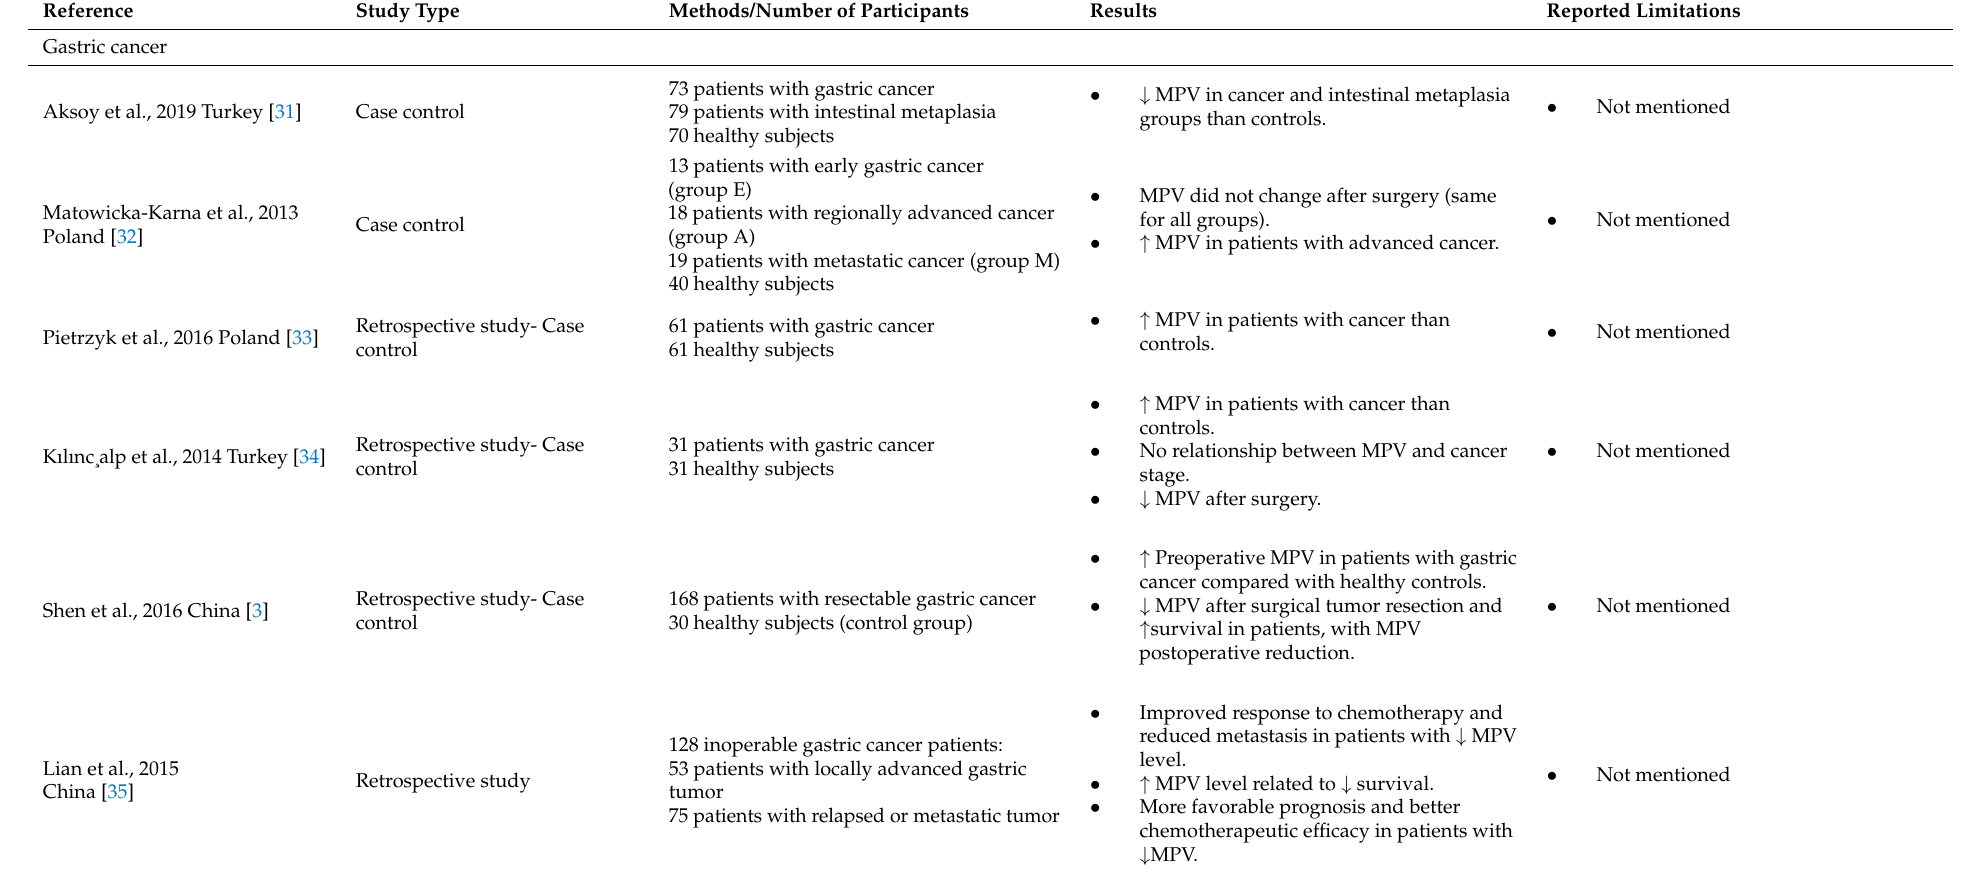
Table 2. Studies relating MPV to gastric, colon, and esophageal